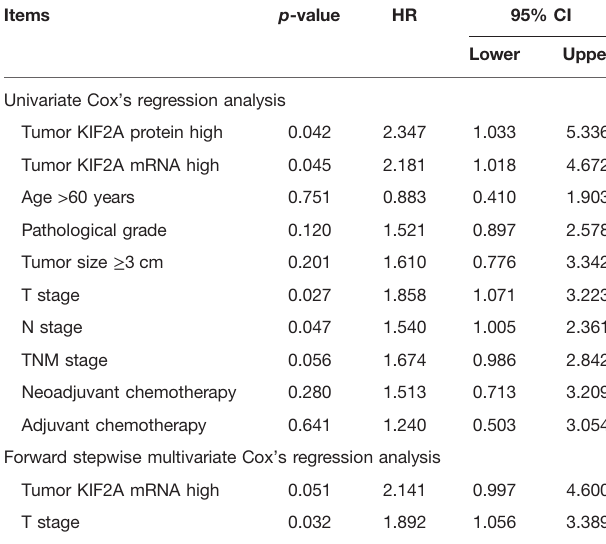
TABLE 3 | Factors affecting DFS by Cox ’ s proportional hazards regression